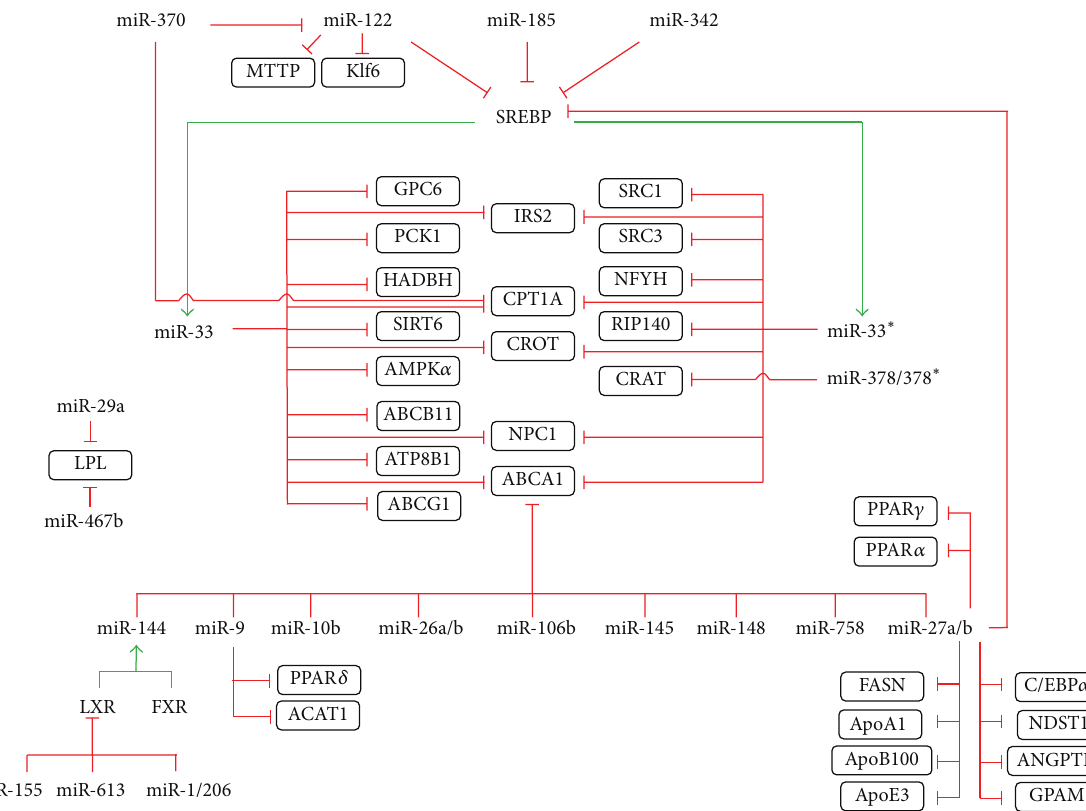
Figure 2: MicroRNAs involved in lipid metabolism. The figure depicts the complex regulation of lipid metabolism by distinct microRNAs. Individual microRNAs are shown together with their confirmed targets (in rectangles); red blunted arrows represent inhibition; green arrows represent stimulation. Figure summarizes the relationships described into greater detail in the text. The abbreviations are also explained in the